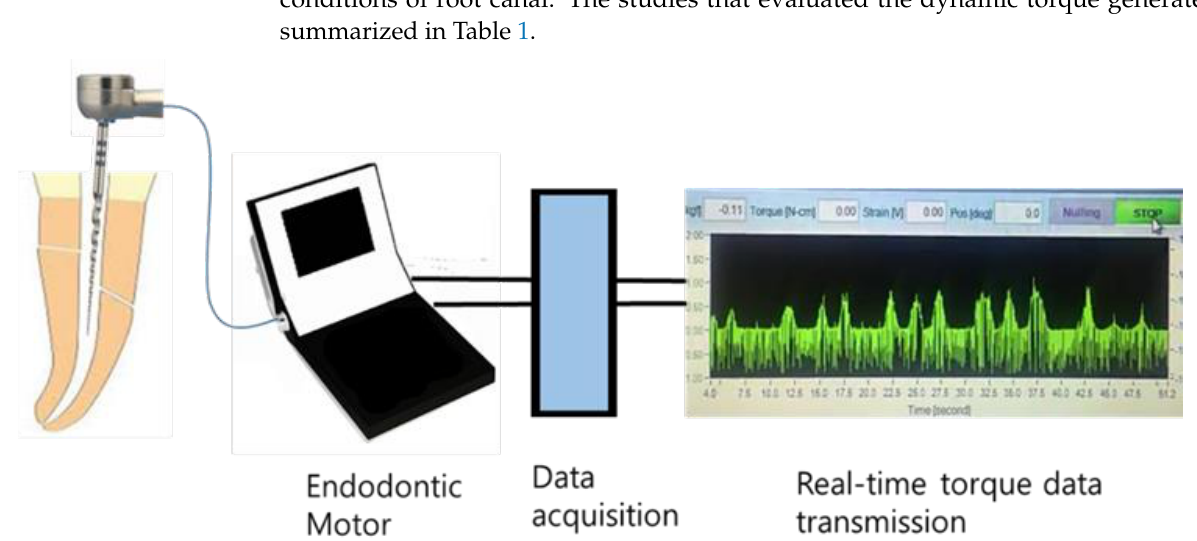
Figure 2. Schematic drawing of experimental set-up for the real-time torque measurement.